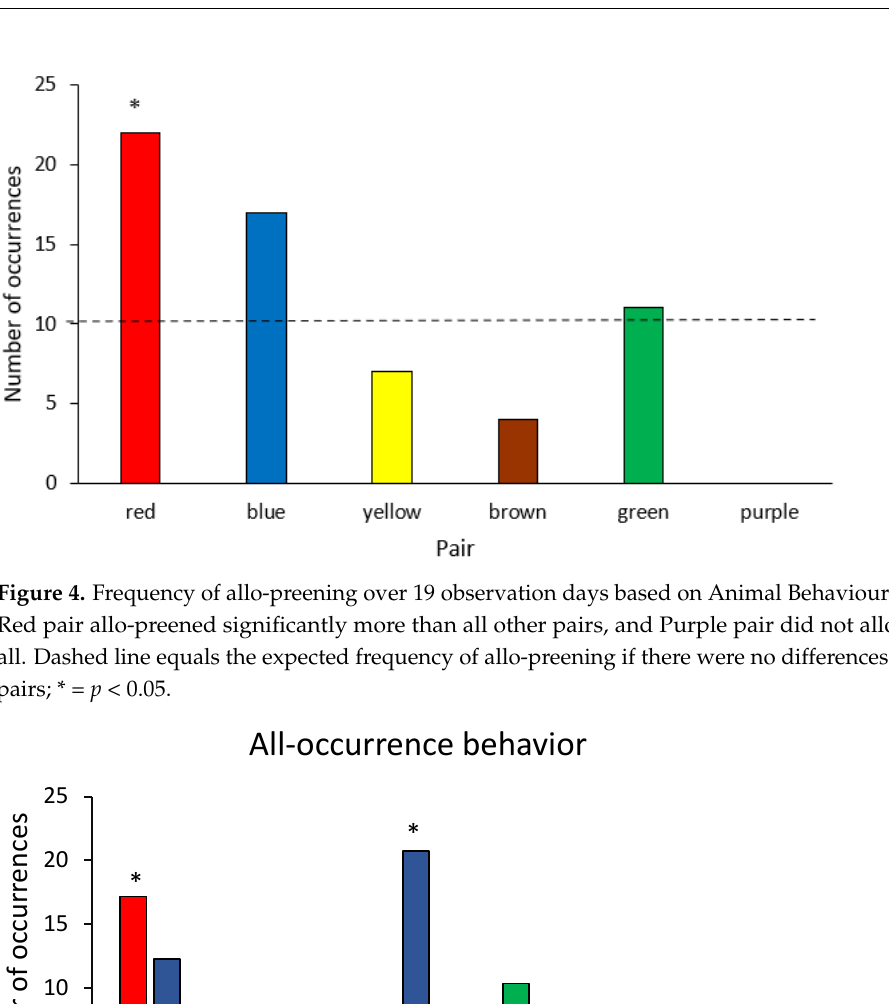
Figure 4. Frequency of allo-preening over 19 observation days based on Animal Behaviour Pro data. Red pair allo-preened significantly more than all other pairs, and Purple pair did not allopreen at all. Dashed line equals the expected frequency of allo-preening if there were no differences amongst pairs; * = p < 0.05.